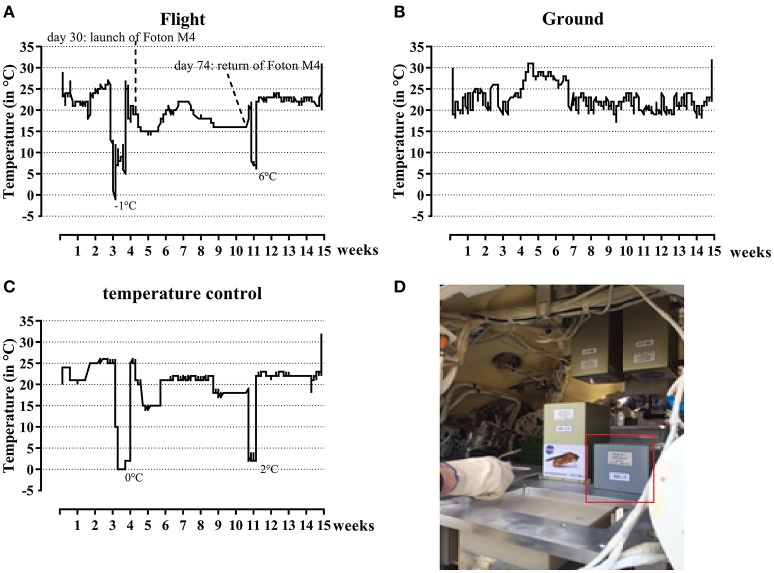
Temperature profiles during the flight experiment and simulated control experiment and its setup in the FOTON capsule. Both during flight (A) and ground (B) temperature profiles were determined. The temperature profile for the flight experiment was later on simulated (C) to determine the effect of these changes on the results. The experiment as set-up in the FOTON capsule is circled in red (D).